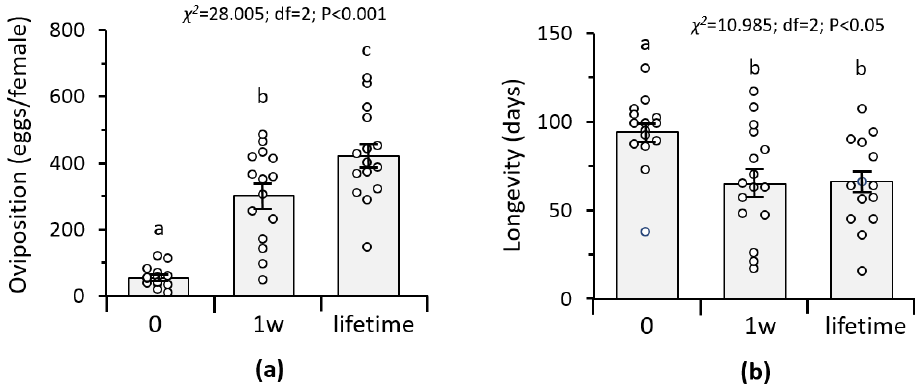
Figure 2. Mean total oviposition ( a ) and longevity ( b ) of Chrysoperla agilis females, depending on the duration of male availability to females for mating: (1) 0: virgin females ( n = 15); (2) 1w: male present for 1 week ( n = 15); (3) lifetime: male present for the female’s lifetime ( n = 15). Different letters indicate significant differences between treatments using Kruskal–Wallis test followed by Mann–Whitney U-test for all pairwise comparisons, p < 0.05.